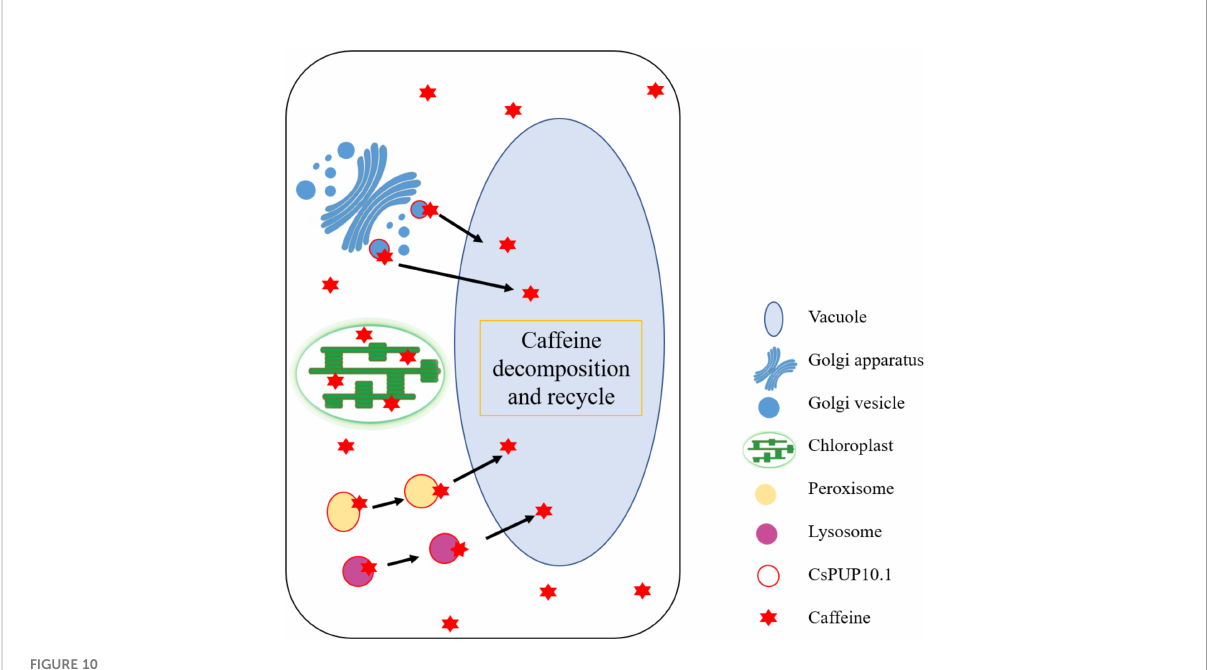
FIGURE 10 Putative mechanism of CsPUP10.1 in caffeine